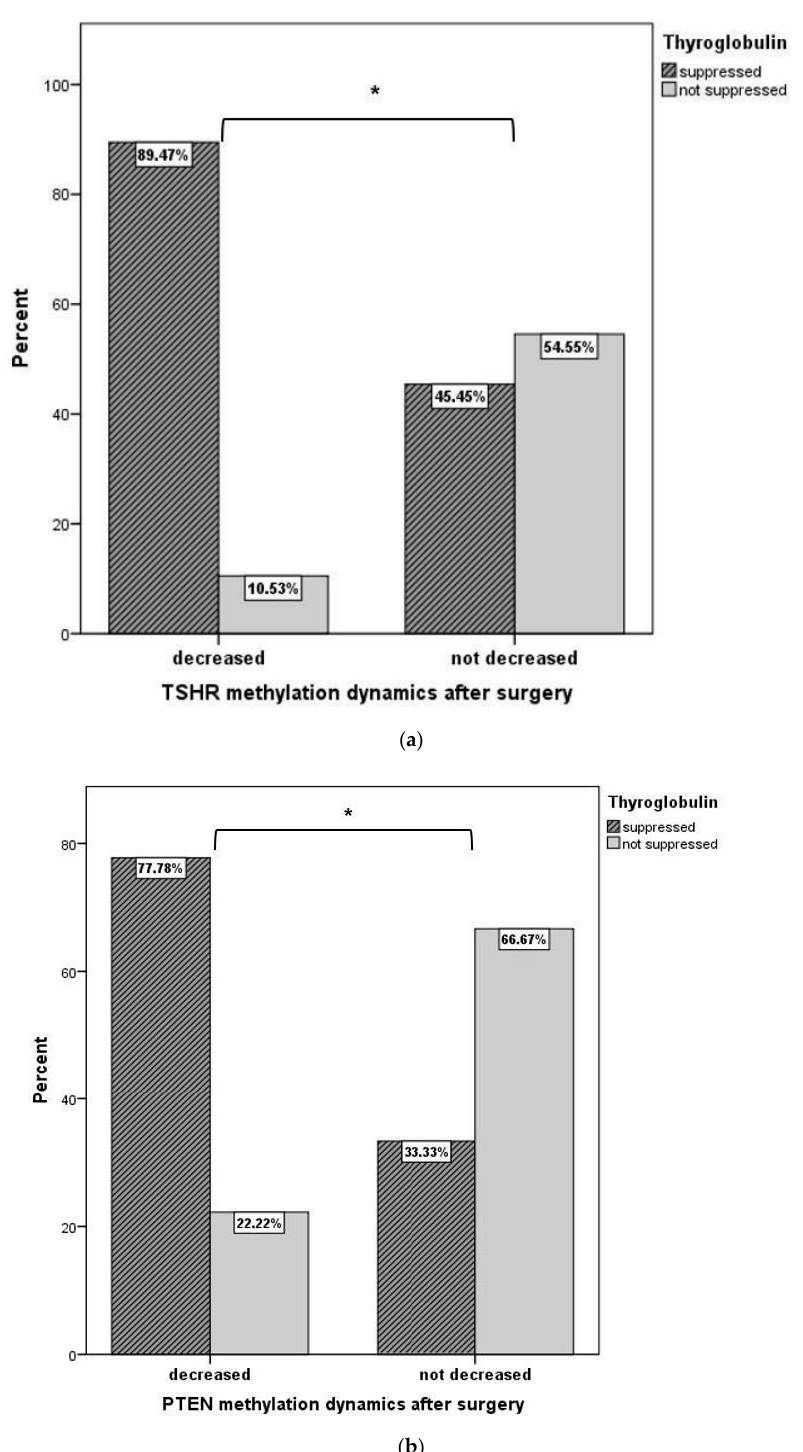
Figure 3. ( a ) The comparison of TSHR methylation level dynamics after surgery in PTC patients with suppressed and not suppressed thyroglobulin. * p < 0.001. A chi-square independence test was used to determine the differences between the comparison groups. ( b ) The comparison of PTEN methylation level dynamics after surgery in PTC patients with suppressed and not suppressed thyroglobulin. * p = 0.038. A chi-square independence test was used to determine the differences between the comparison